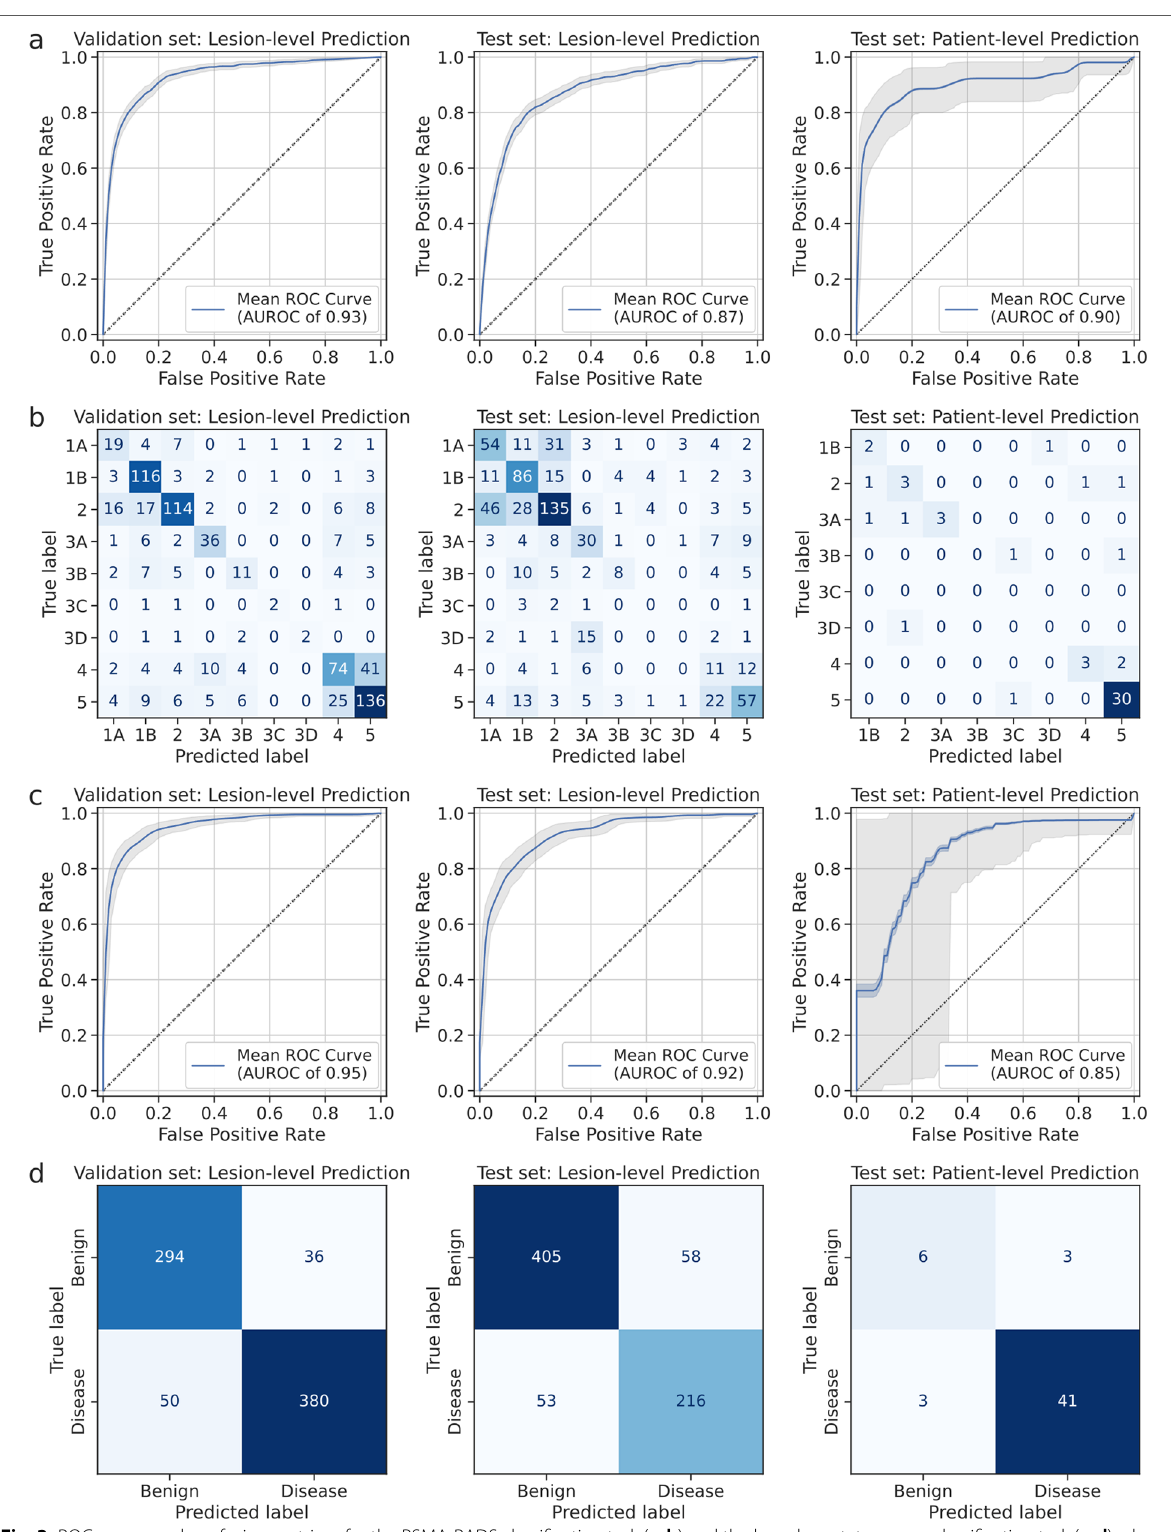
Fig. 3 ROC curves and confusion matrices for the PSMA-RADS classification task ( a , b ) and the broad prostate cancer classification task ( c , d ) when using the automatically extracted inputs. The shaded blue and gray areas correspond to the 95% confidence intervals and the 95% tolerance intervals on the ROC curves,